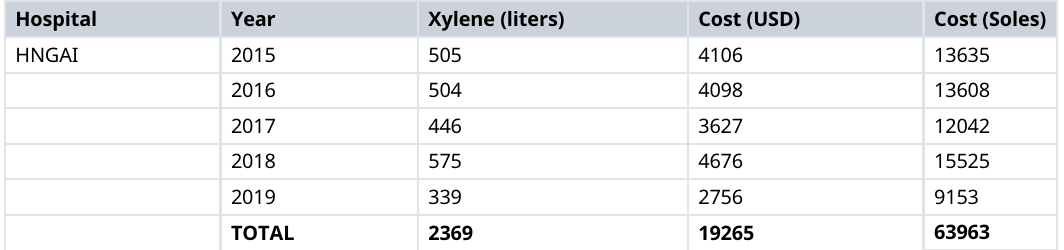
Table 1. Use of xylene and costsin four EsSalud hospitals. These data were estimated according to the amount of annual Pap tests during 2015 –